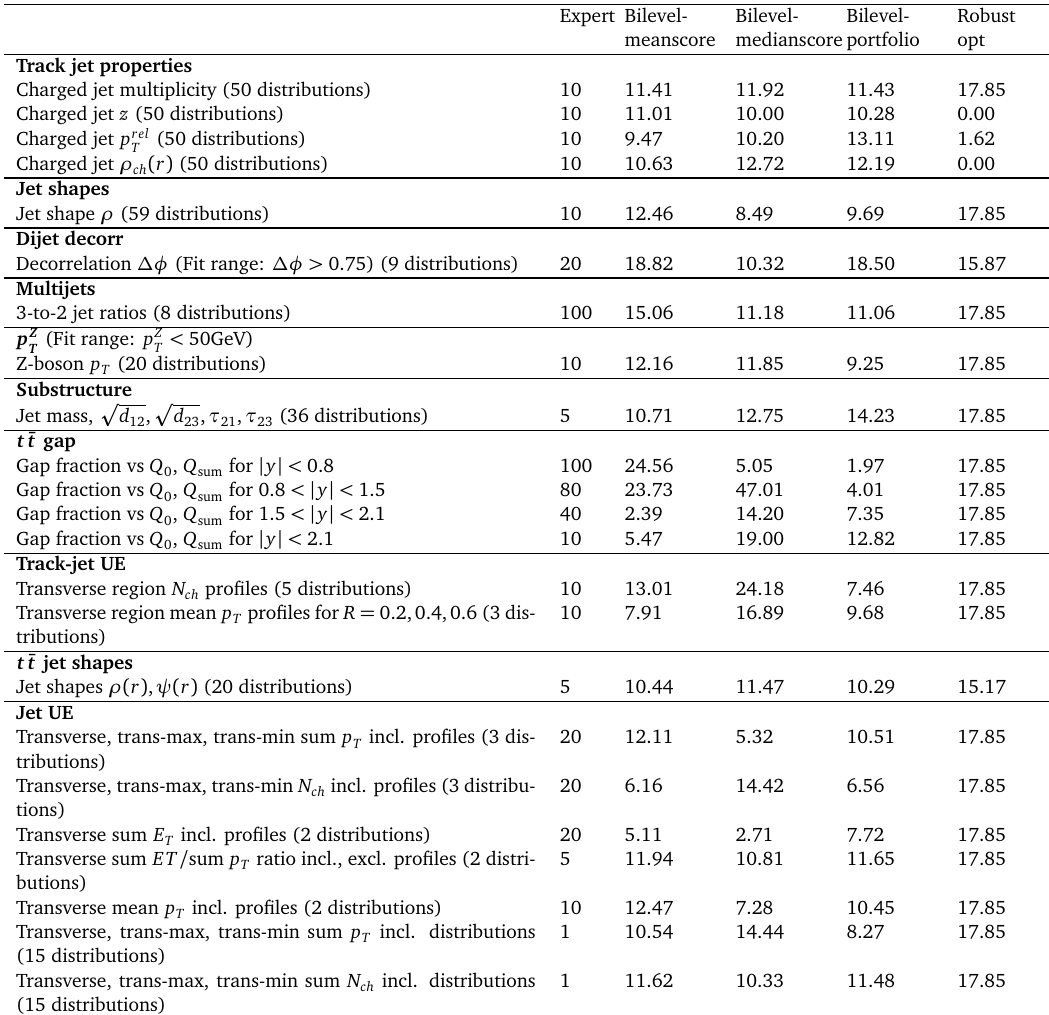
Table 7: Comparison of the optimal weights obtained by each method using the rational approximation. The observable grouping corresponds to the same grouping as in [ 3 ]